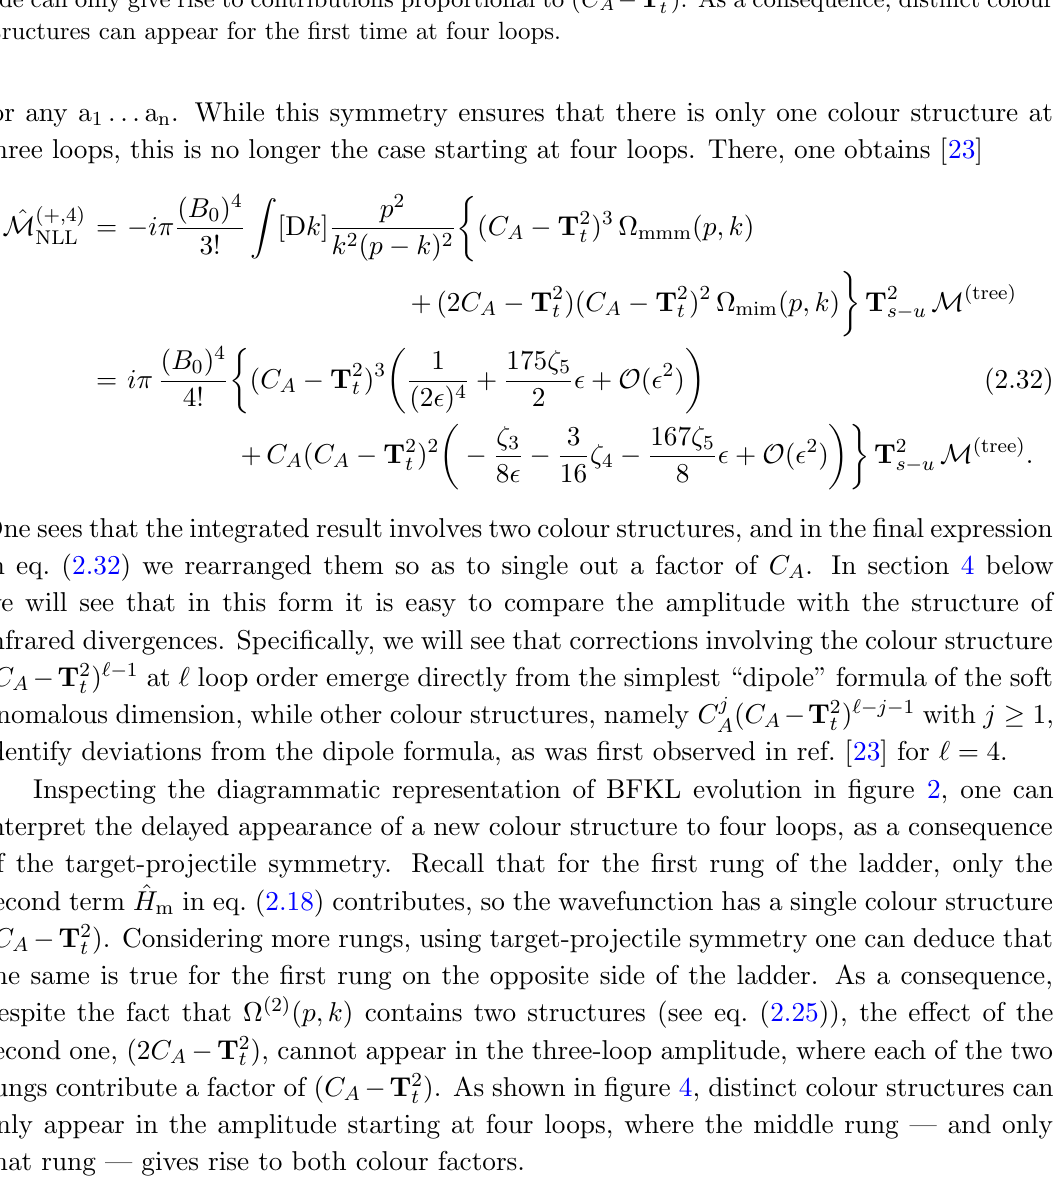
). As a consequence, distinct colour t